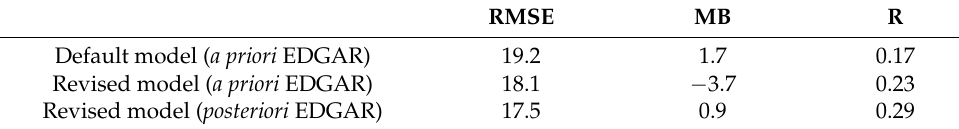
Table 2. Statistics for different simulation cases for hourly CO 2 during midnight.